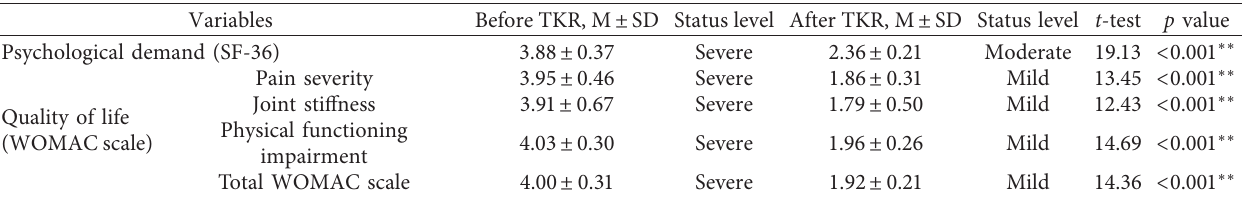
Table 3: The quality-of-life differences among patients before and after TKR ( N �